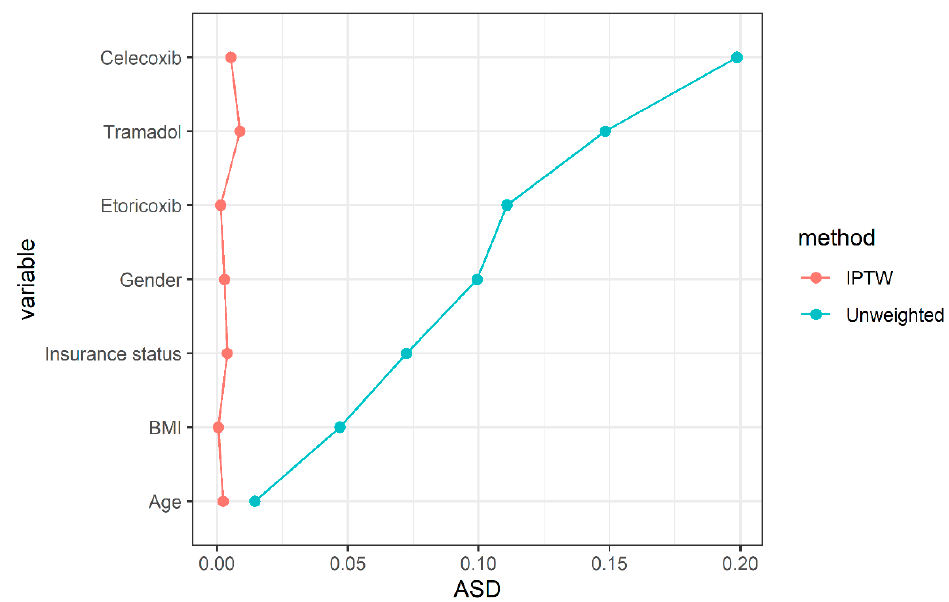
Figure 2. Distribution of absolute standardized differences in the unweighted and weighted samples.